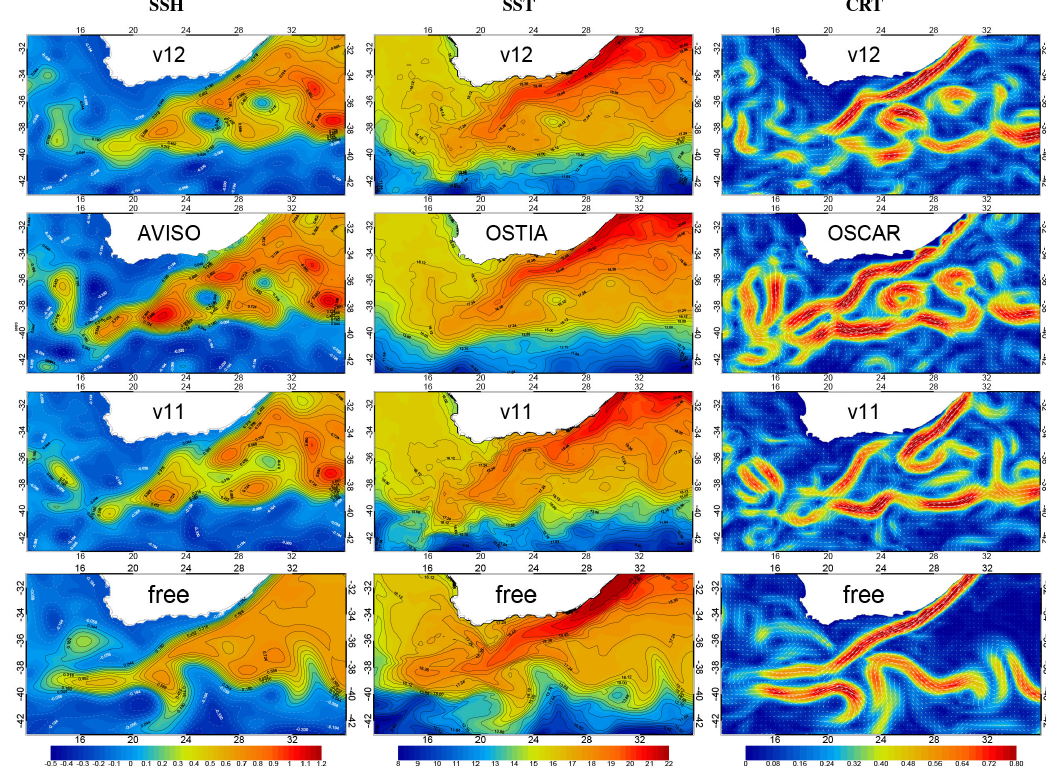
Figure 10. An array of monthly-mean gridded contour plots over the Agulhas retroflection region (longitude: 12–36 ◦ E; latitude: 31–43 ◦ S) for September 2012. Sea surface height (left column; m) and temperature (centre column; ◦ C) are plotted as coloured contours and overlaid with black contour lines. For the SSH plots solid black lines denote positive contour values and broken white lines are used for negative values. Surface currents (right column; m s − 1 ) are displayed as coloured contours of current intensity (speed), with white arrows overlaid to show direction. Output from the v12, v11 and free trials are plotted in the first, third and fourth rows respectively, whilst the second row plots show the gridded observational products: AVISO SSH, OSTIA SST and OSCAR near-surface currents. Model currents shown (i.e. v12, v11 and free) are total integrated velocity over the top 15m. Anomaly correlations for each of the modelled fields against the corresponding gridded observations can be found in Table